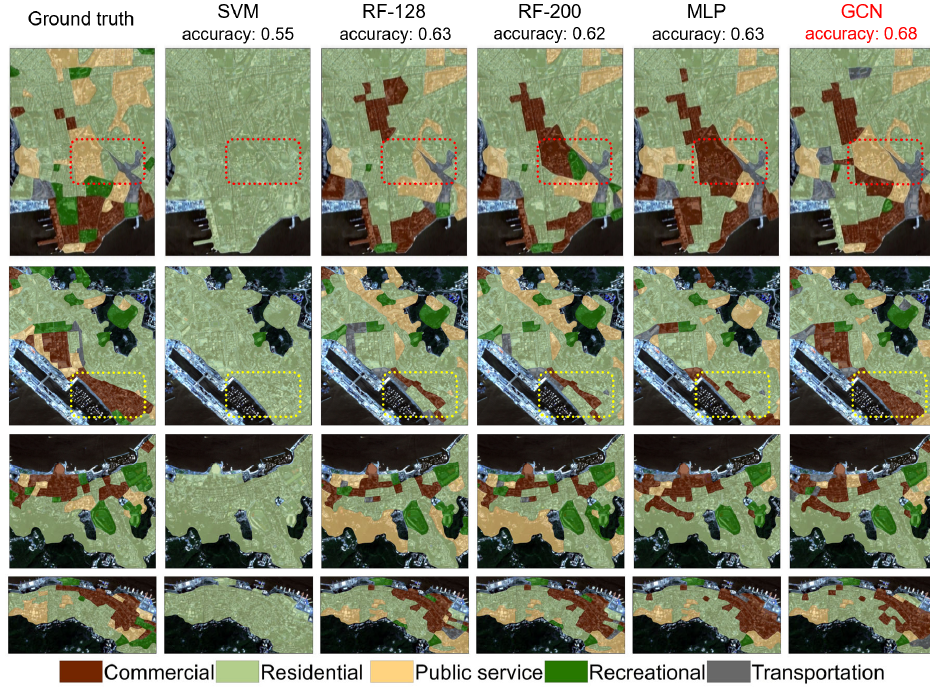
Figure 6. Visual comparison between ground truth and five functional land use prediction results obtained from SVM, RF-128, RF-200, MLP and GCN. The number of training samples is set as 4.7% (known/unknown: 22/469) of the total region, and the accuracy is highlighted accordingly.